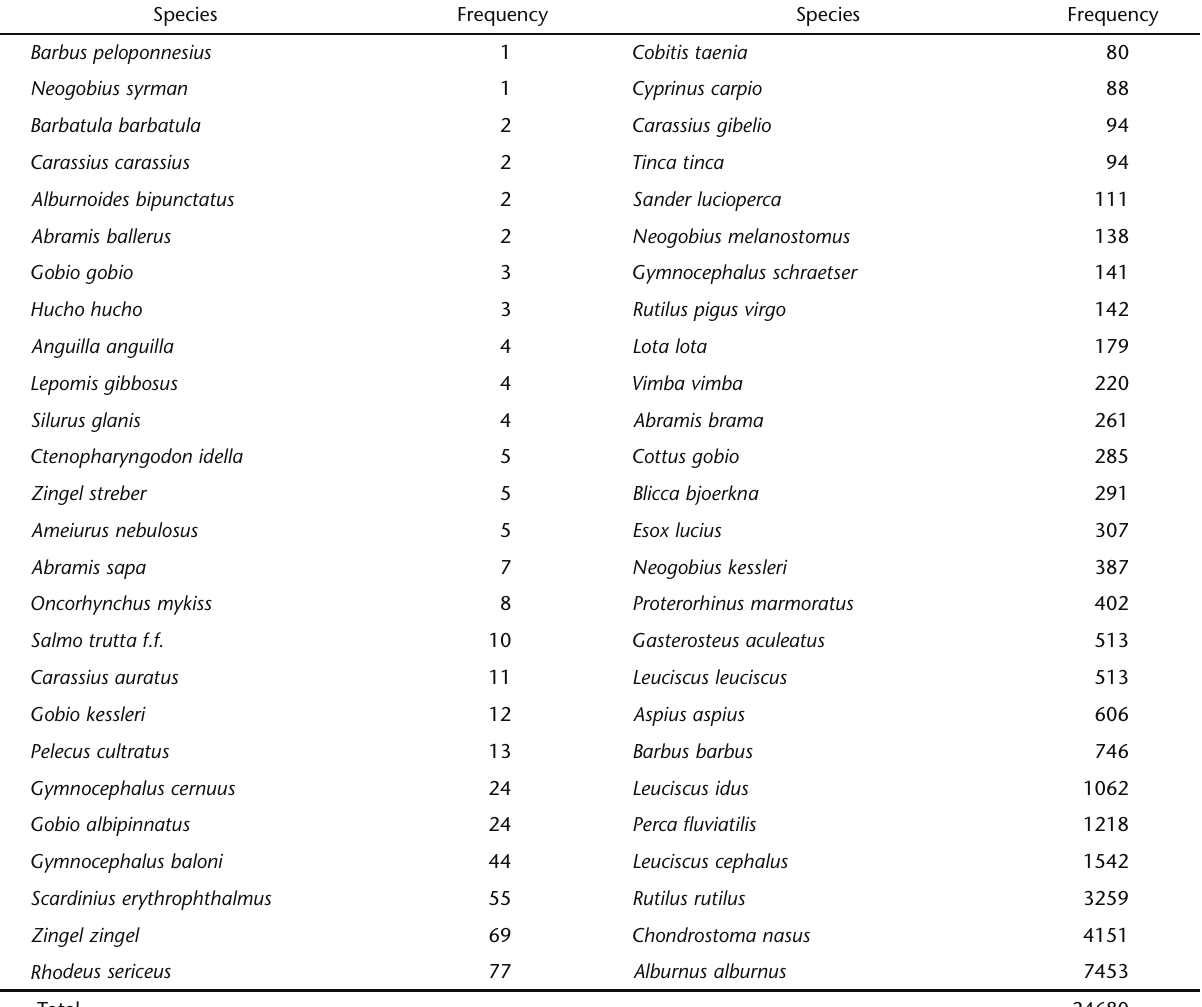
Table I. Fish frequencies at the study site, Danube River, Vienna, Austria.